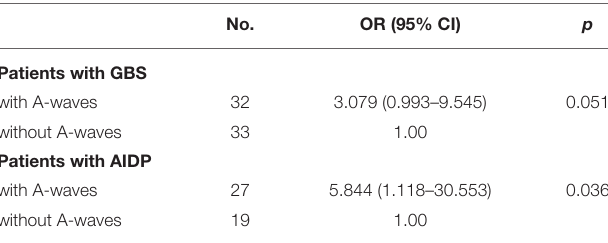
TABLE 2 | A-wave as a risk of poor outcome, defined as the inability to walk unaided at 1 month since symptom onset based on binary logistic regression analysis.